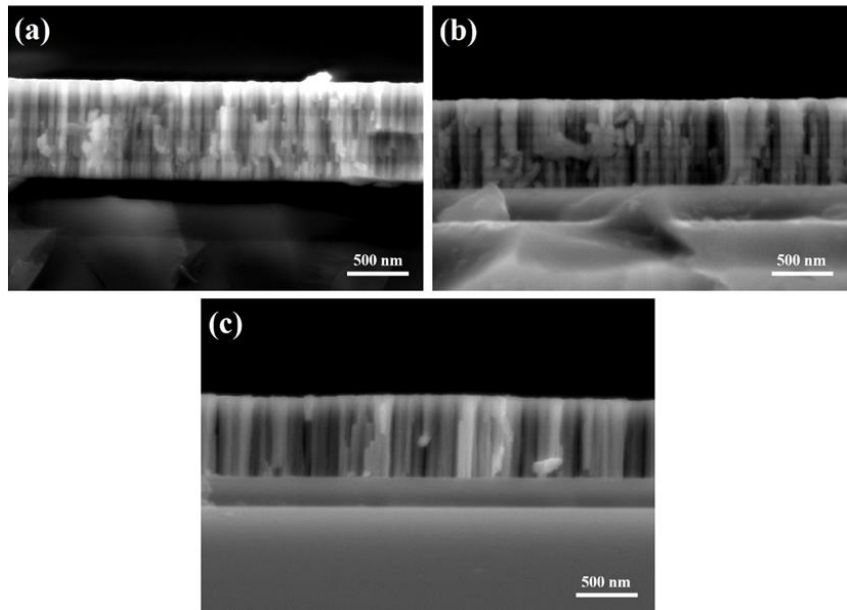
Figure 4. Cross-sectional FE-SEM images of as-sputtered Ni/Ni 3 Al-MoW multilayers with different h : ( a ) 160 nm; ( b ) 40 nm; ( c ) 10